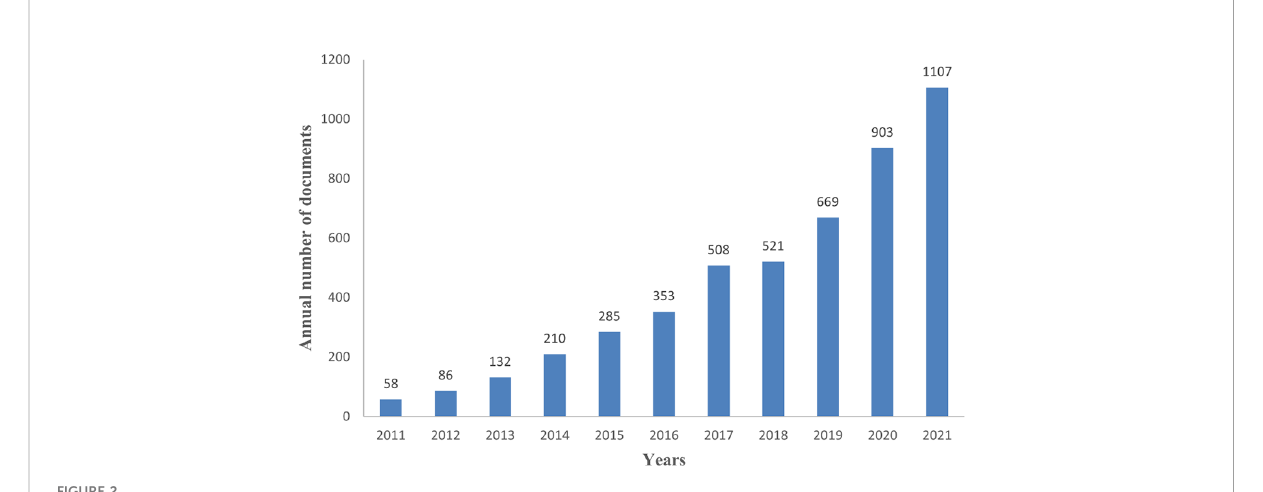
FIGURE 2 Trends in posting volume annually.